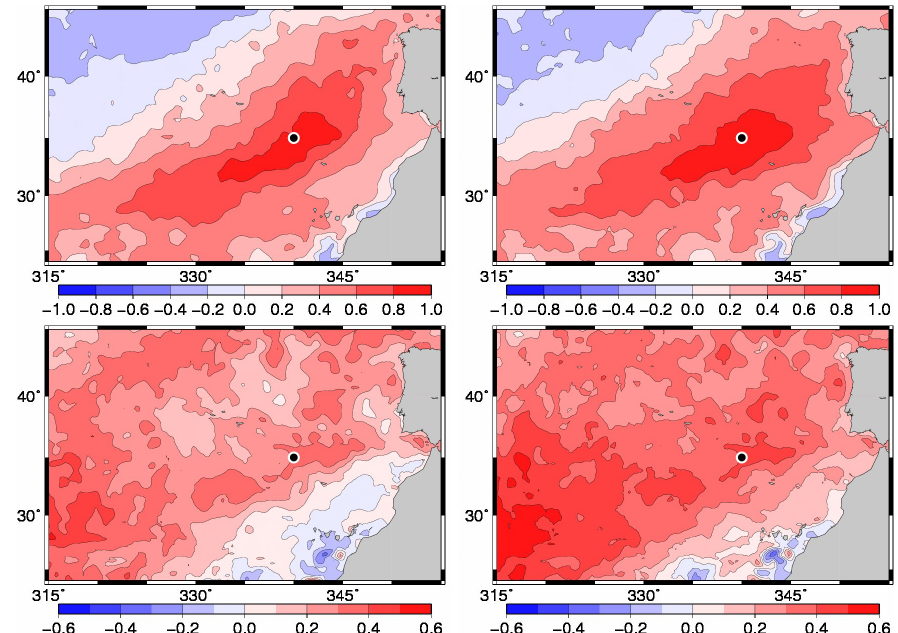
Fig. 14. Phytoplankton (top panels) and nitrate (bottom panels) horizontal correlation structure with respect to phytoplankton at 20 ◦ W 35 ◦ N (North Atlantic), without anamorphosis (left panels), and after local anamorphosis transformations (right